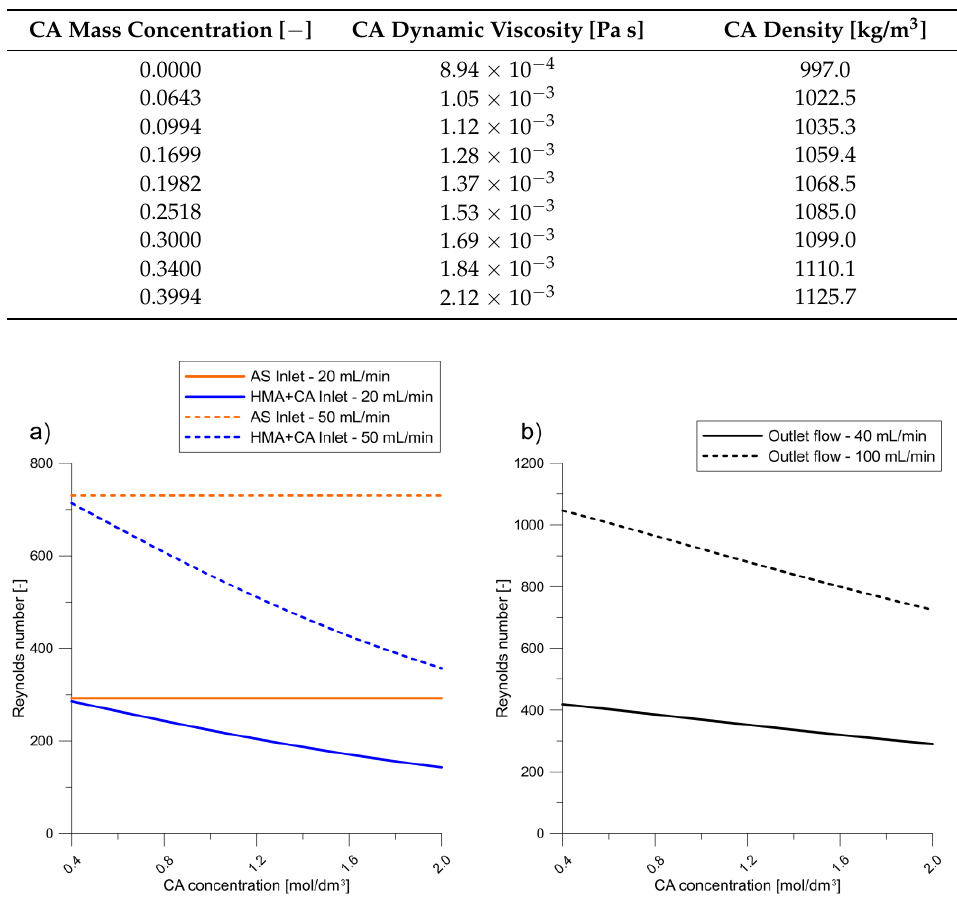
Table 3. CA properties at 298.15 K according to Ref. [31].